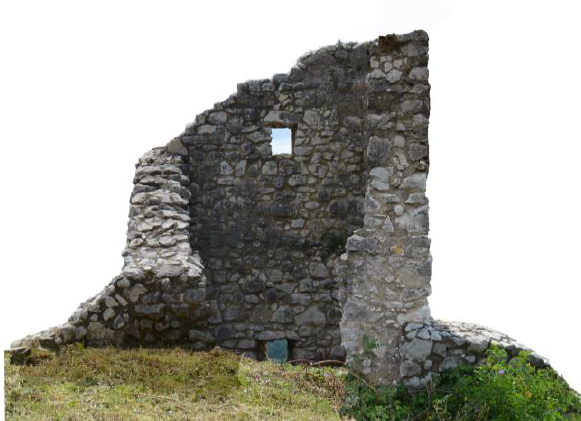
Figure 11: orthophoto of a tower.